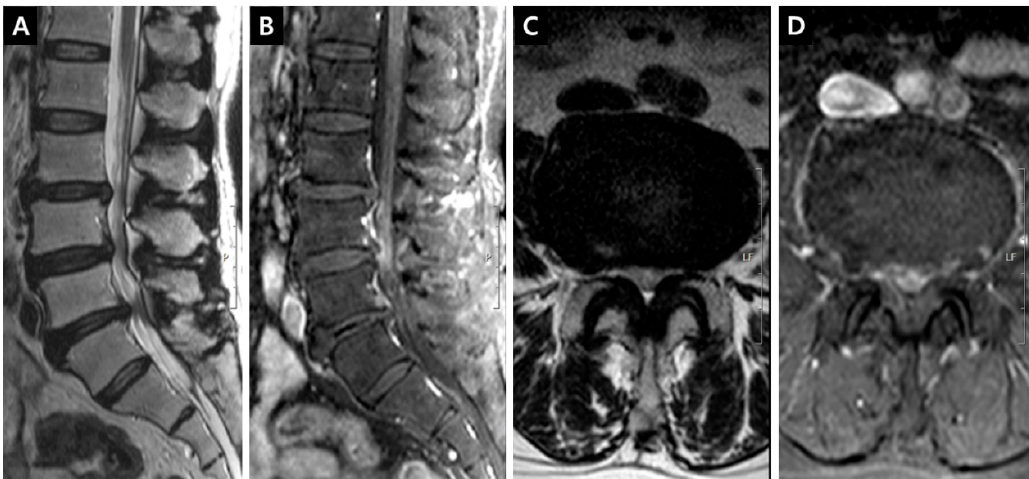
Figure 4. Enhancement patterns: intraradicular vein of cauda equina (IRCE). ( A ) T2-weighted midsagittal image showing L3-4 central protrusion, L4-5 central stenosis, and L5-6 central protrusion; ( B ) Fat-suppressed enhanced T1-weighted midsagittal image revealing the prominent enhancement of intradural rootlets on the L4-5 disc level; ( C ) T2-weighted axial image on the L4-5 disc level; ( D ) Fat-suppressed enhanced T1-weighted axial image on the L4-5 disc level, the definite enhancement of rootlets in the thecal sac can be seen.